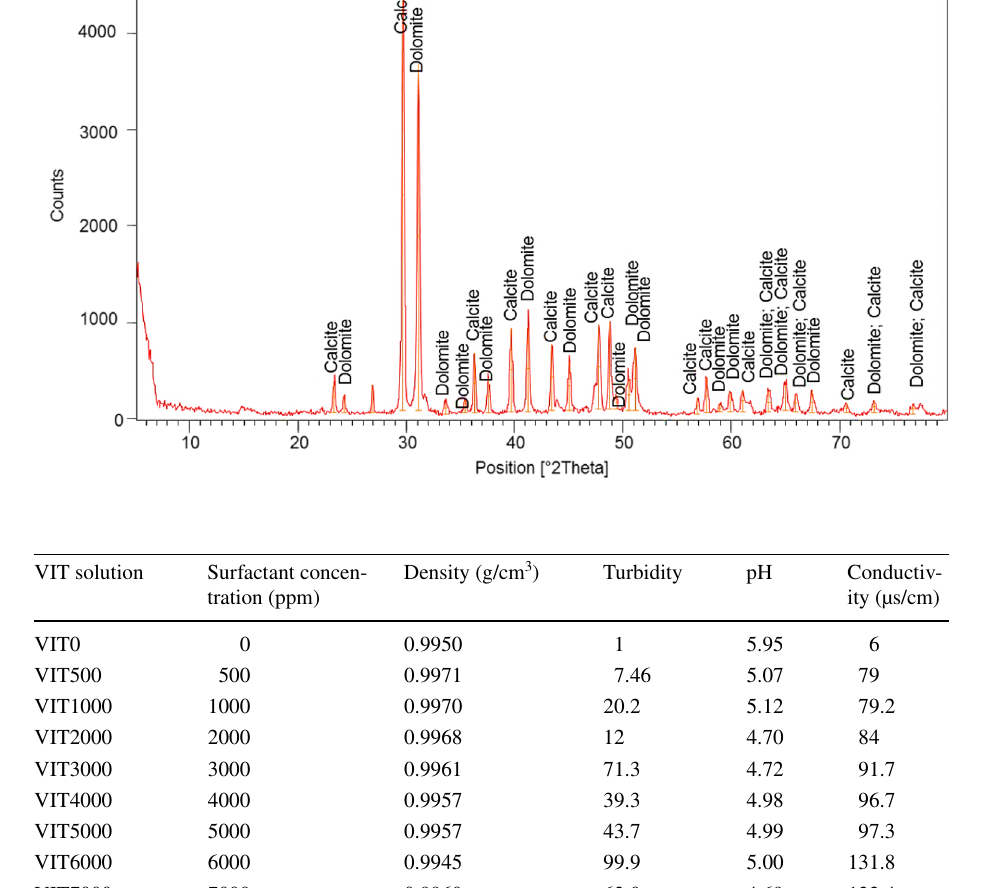
Fig. 4 XRD analysis of the used